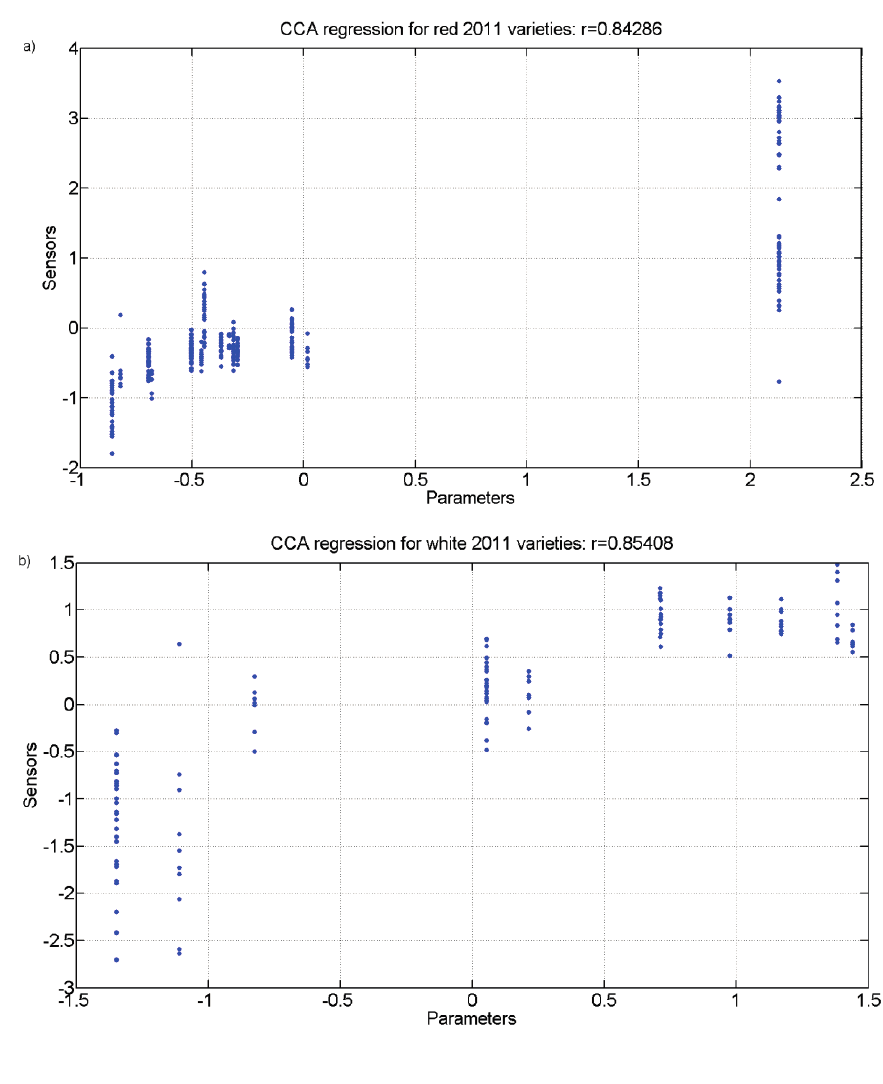
Figure 10. r values for the canonical correlation between grape must parameters and sensor responses for grape must varieties of 2011. ( a ) Red varieties; ( b ) White